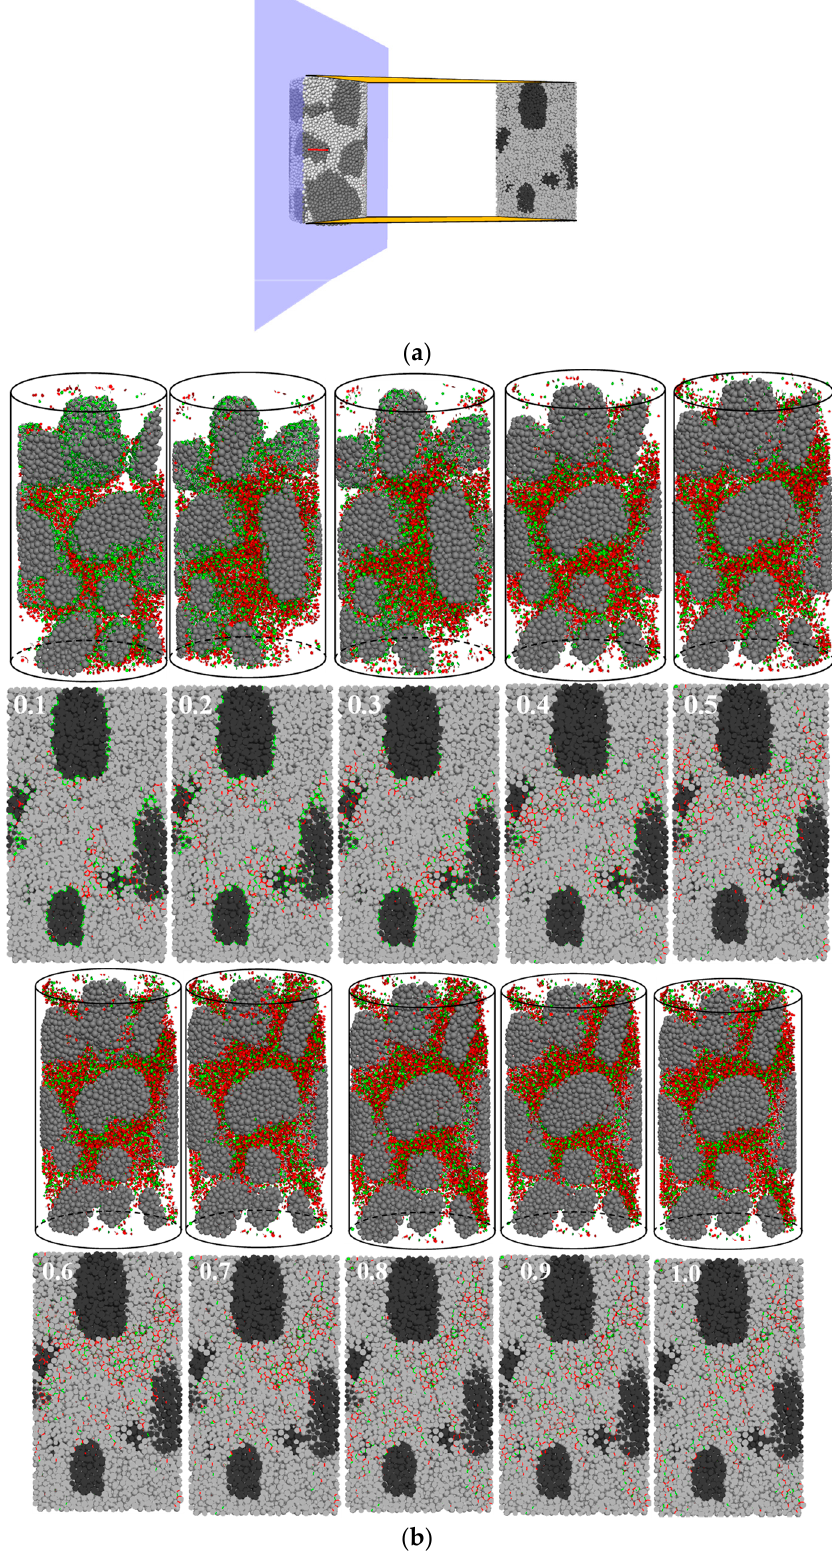
Figure 5. Fracture propagation patterns with different cementation strength. ( a ) Projection diagram of three-dimensional discrete element model; ( b ) Crack morphology under uniaxial compression with different cementation strength ratios (shearing cracks in green and tensile cracks in red).